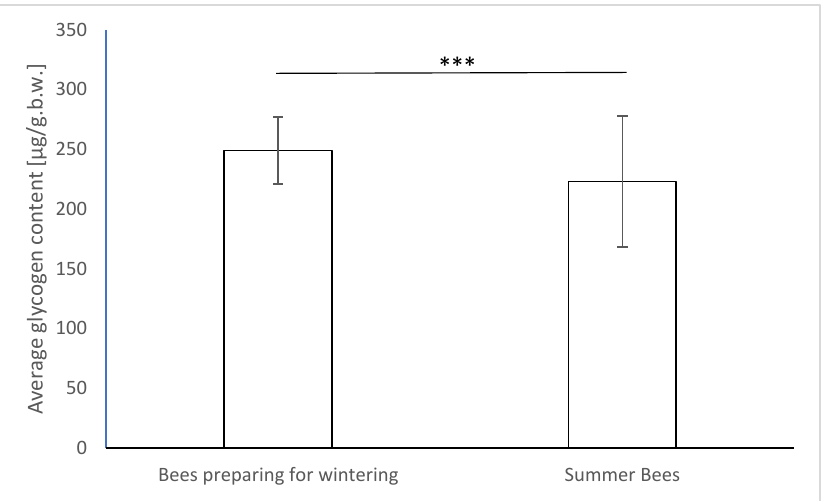
Figure 3. Differences between the general average glycogen contents (in μg/g.b.w.) in bee organisms depending on the sampling season. Statistical significance was determined *** p < 0.001).